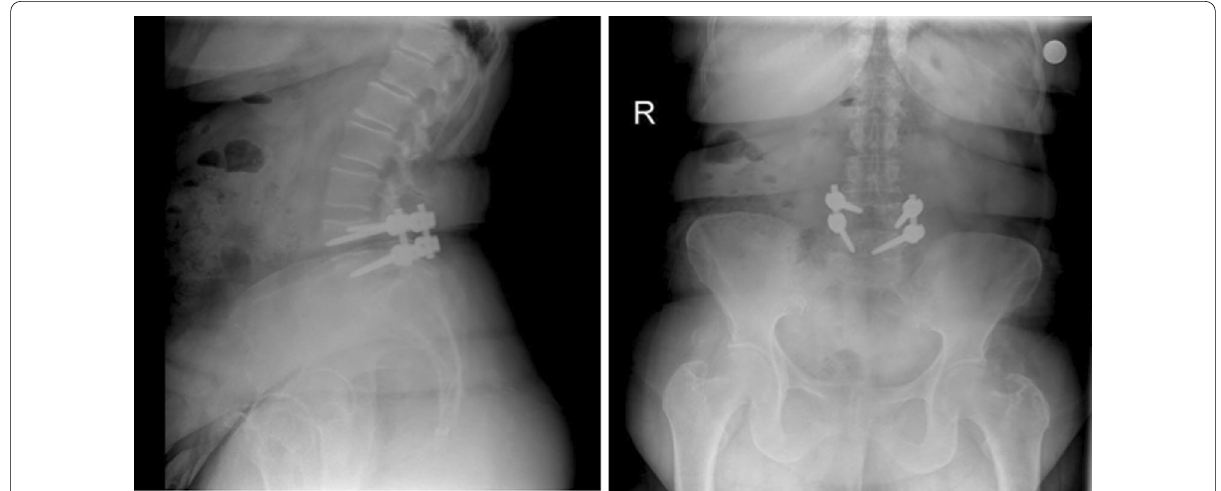
Fig. 1 Preoperative lumbo-sacral spinal direct graphy—lateral and AP